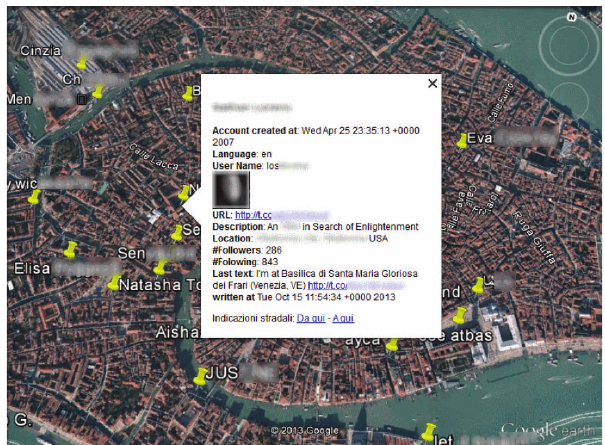
Figure 13: Personal and sensitive information available in the metadata of a single